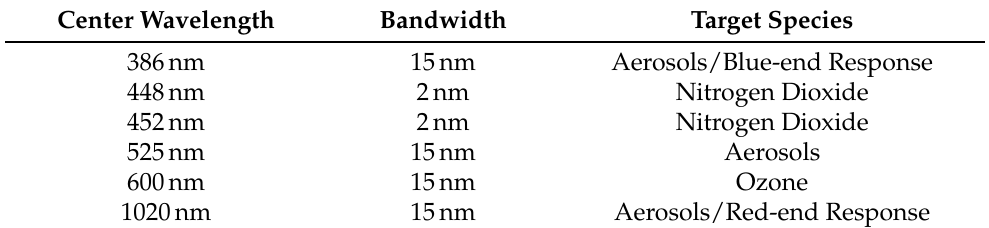
Figure 2. SAGE IV filter wheel with filters, diffuser, and light block. Table 2. Bandpass filters in the